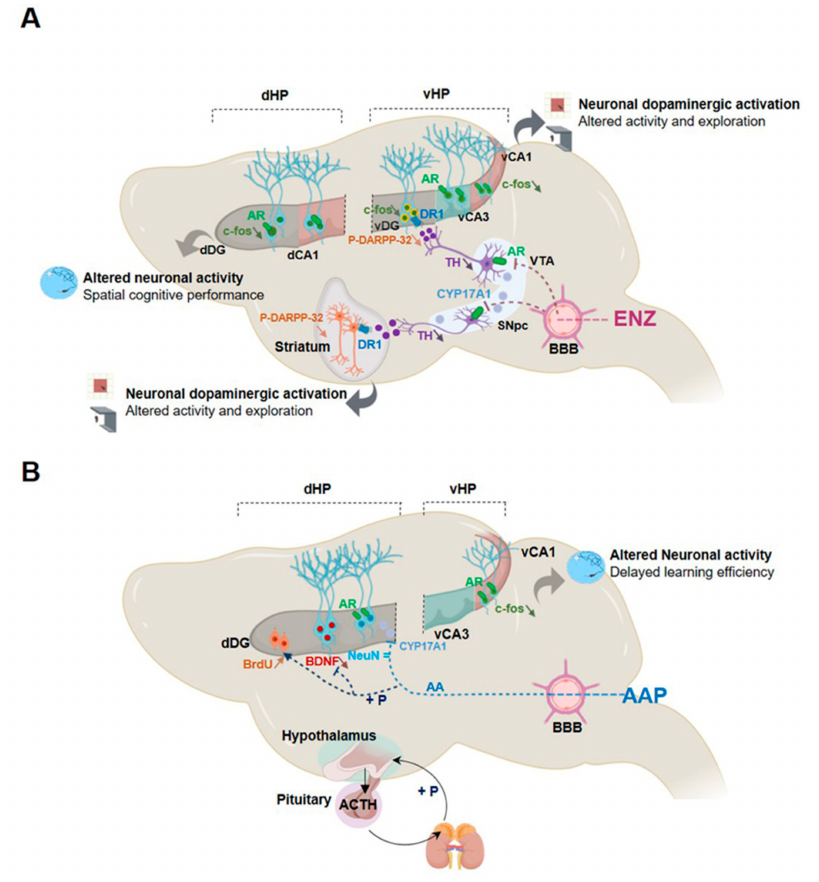
Figure 9. Schematic illustration of the central action of novel generation hormone therapy targeting the androgen signaling axis, abiraterone acetate+prednisone (AAP) and enzalutamide (ENZ) in aged castrated mice. Note. ( A ) ENZ which is able to cross the blood–brain barrier (BBB) can bind and in- hibit ARs expressed in peripheral and brain organs. More specifically, CYP17A1 and AR are localized in both SNpc and VTA neurons in aged castrated mouse brains. ENZ leads to reduced P-DARPP-32 activated signaling in mature neurons expressing DR1 in the striatum through the nigrostriatal pathway and in the vHP via part of the mesolimbocortical pathway. This inhibition of DA-expressing afferents likely accounts for diminished locomotor activity and exploration behavior. ENZ also depressed mature neuron activity evidenced by c-fos expression in dHP potentially responsible for an altered spatial cognitive performance. ( B ) AAP is a prodrug, generating abiraterone selective for CYP17A1 enzyme activity, thus inhibiting androgen biosynthesis in the testis and the adrenal gland, but potentially in the VTA and SNpc. AA may have the ability to cross the BBB. In order to avoid cortisol deficiency, the treatment is combined with chronic use of prednisone (P) sufficient to activate the HPA-related feedback loop and to reduce the plasma ACTH level allowing physiological cortisol production in patients. CYP17A1 and AR are expressed in the dHP, and here the AAP effect on proliferation of precursor cells and inhibition of BDNF production without modification of mature neurons would hypothetically involve glucocorticoids receptors. In the vHP, the AAP-evoked reduc- tion of c-Fos in mature neurons can sustain the delay in efficiency in spatial learning acquisition. AA, abiraterone acetate; AAP, abiraterone acetate-prednisone; ACTH, adrenocorticotropic hormone; AR, androgen receptor; BBB, blood–brain barrier; BDNF, Brain-derived neurotrophic factor; c-fos, cellular oncogene c-fos; CYP17A1, Cytochrome P450 Family 17 Subfamily A Member 1; DA, dopamine; dHP, dorsal hippocampus; ENZ, enzalutamide; HPA, hypothalamic–pituitary–adrenal; P, prednisone; P-DARPP-32, Phosphorylated form of Dopamine cAMP-Regulated Neuronal Phosphoprotein; DR1, DA receptor 1; SNpc, substantia nigra pars compacta; vHP, ventral hippocampus; VTA, ventral tegmental